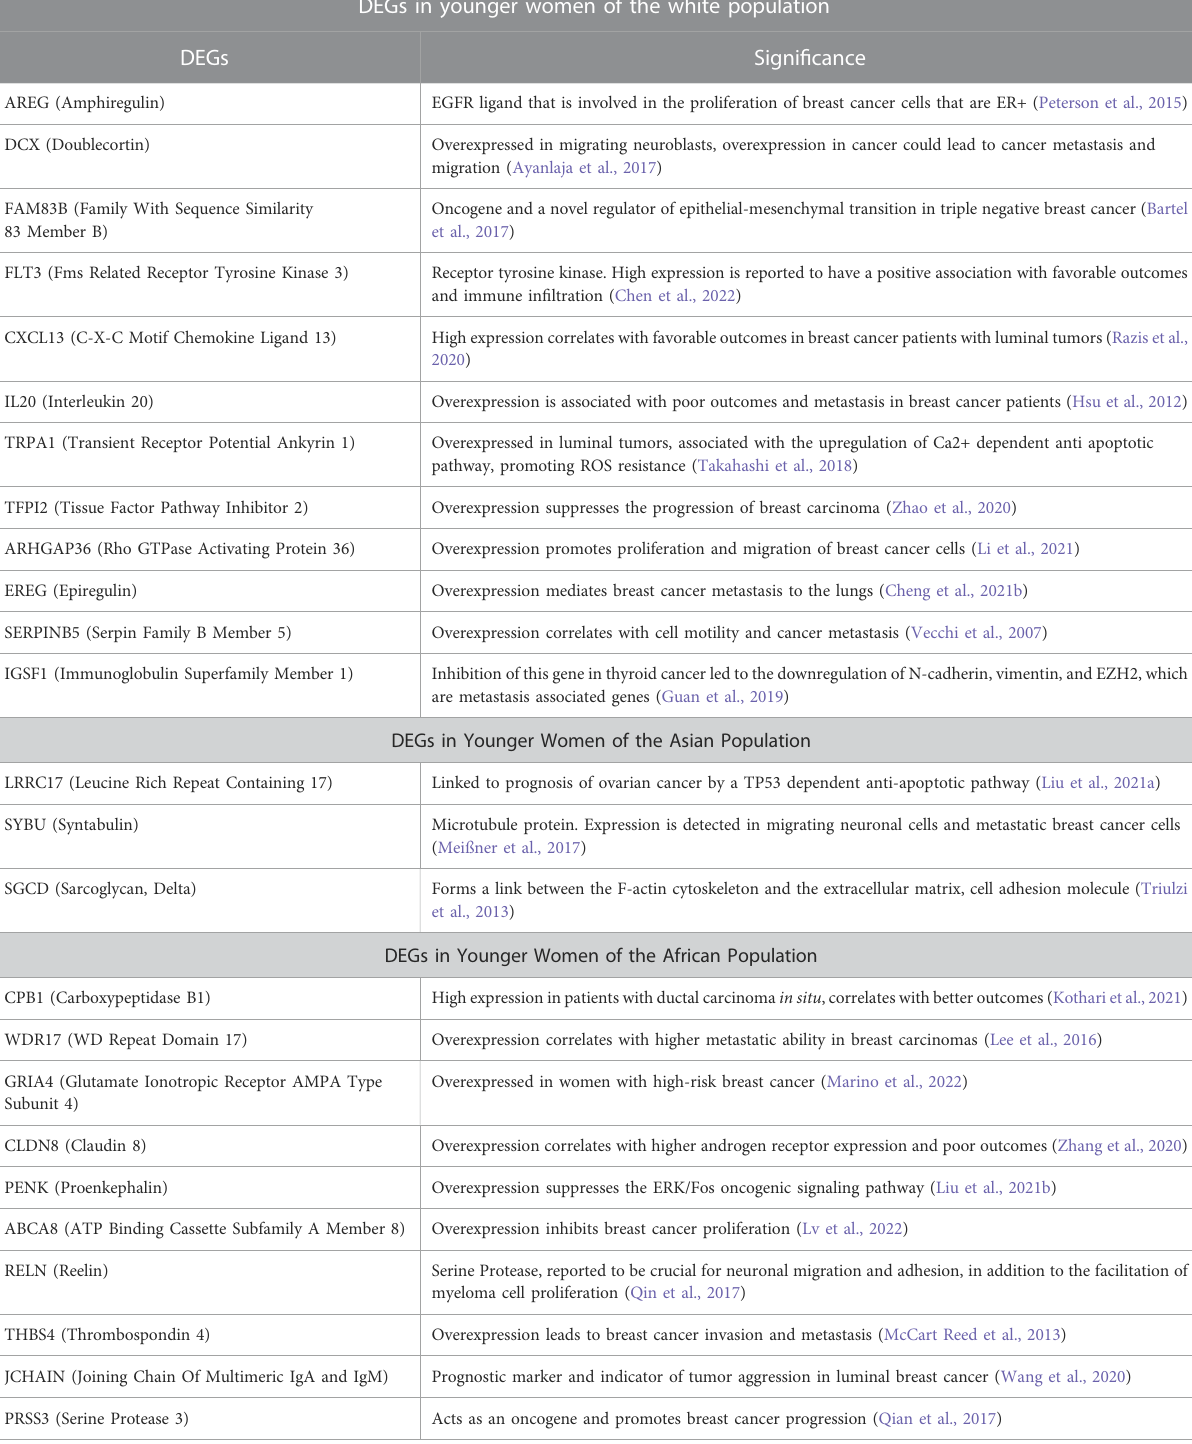
TABLE 3 Differentially expressed genes and their signi fi cant roles in